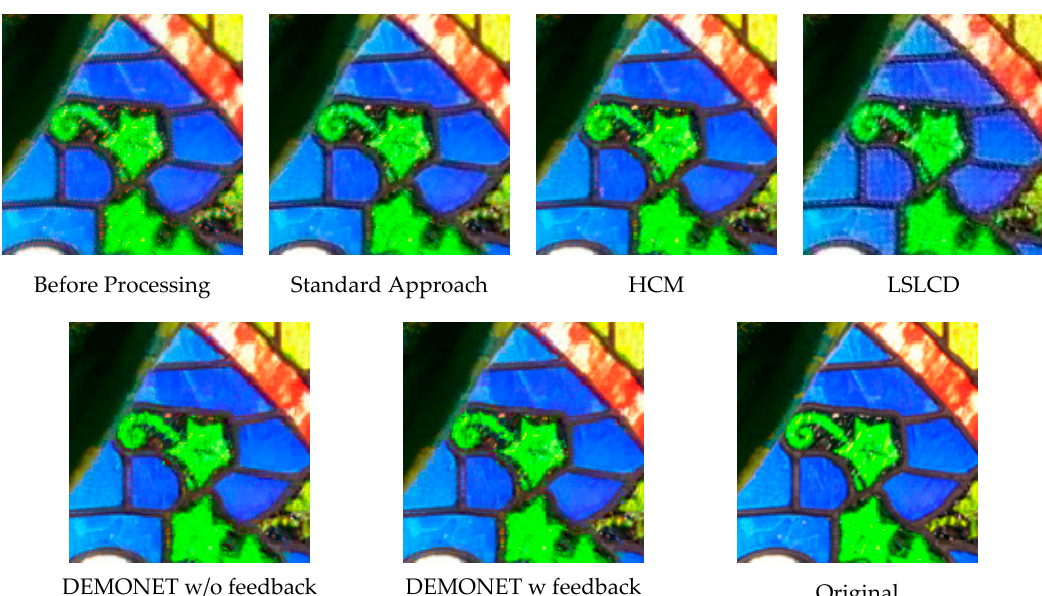
Figure 11. Averaged CIELAB values of different methods.